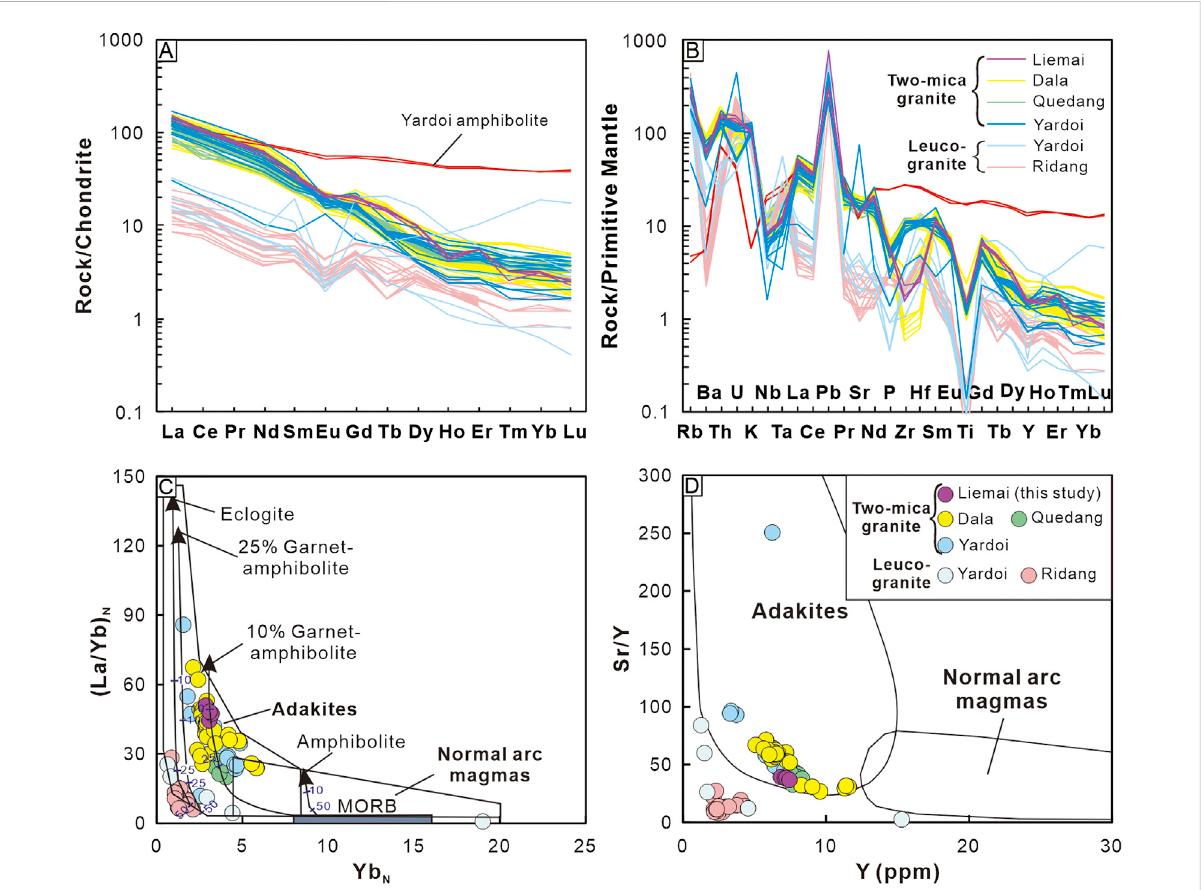
FIGURE 6 (A) Chondrite-normalizedREEpatterns, (B) primitivemantle-normalized traceelementpatterns, (C) Yb N vs.La N /Yb N and (D) Yvs.Sr/Ydiagrams for the Liemai two-mica granite (Martin, 1986; Defant and Drummond, 1990). Subscript N represents chondrite-normalized value. Chondrite and primitivemantlevaluesarefromSunandMcDonough(1989).Datasource:theamphiboliteintheYardoiareawasfromHouetal.(2012);thegranites/ leucogranites are same as in Figure